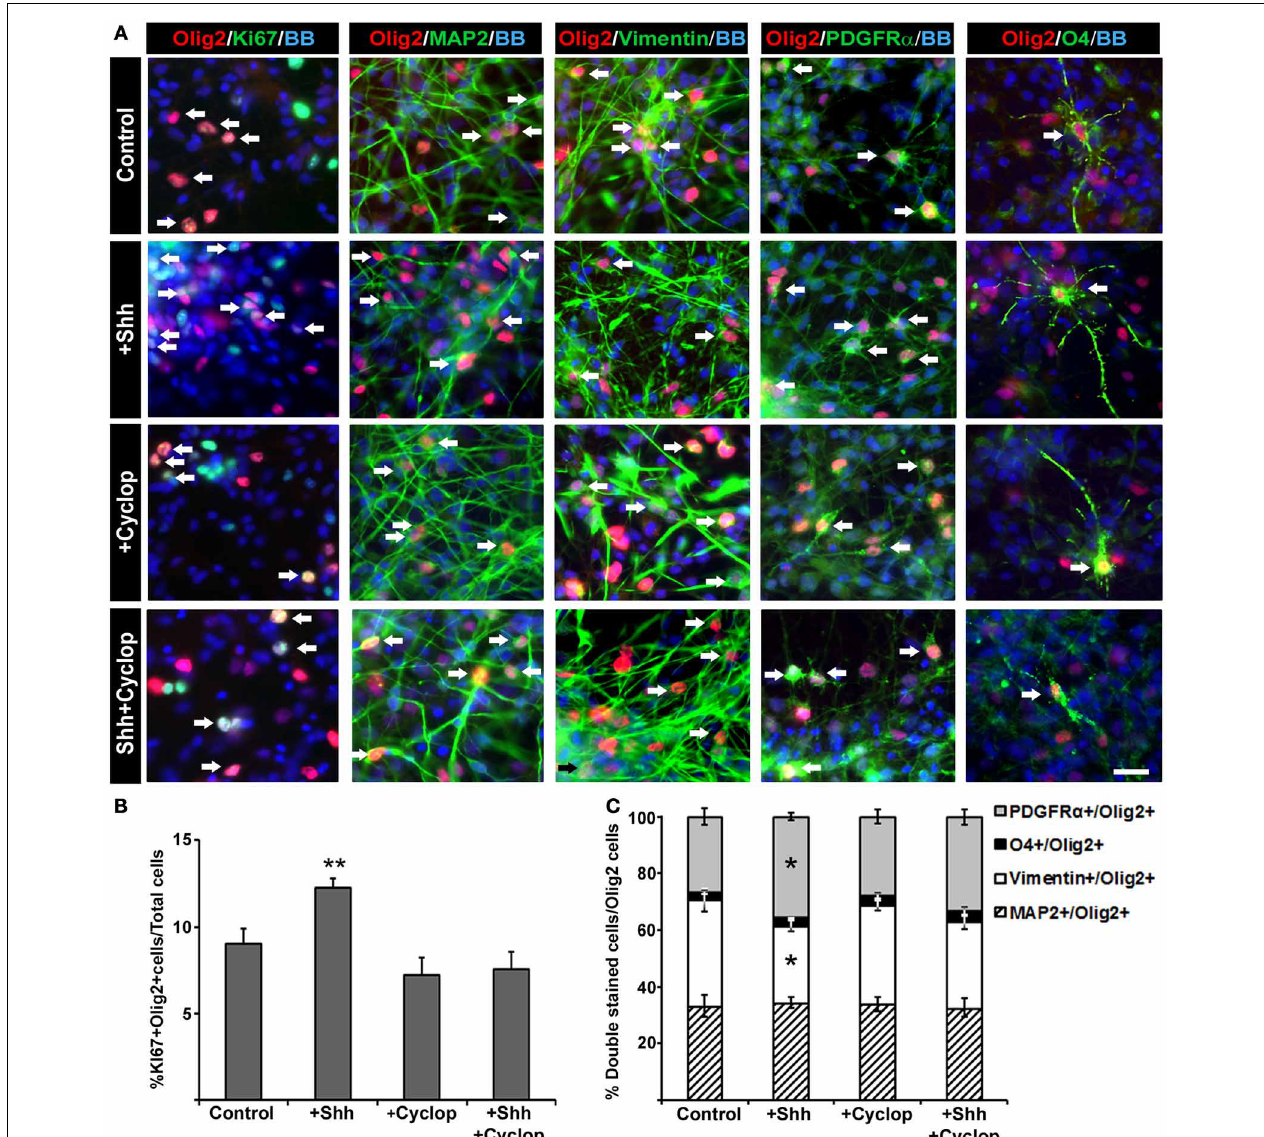
FIGURE 4 | The effect of Shh signaling on proliferation and differentiation of Olig2 + cells in vitro . (A) In mixed cell cultures at midgestation, Olig2 + cells (red) were co-labeled with Ki67 (cell proliferation marker), MAP2 (neuronal marker), vimentin (RGC marker), PDGFR α (early OPC marker) and O4 (late OPC marker) in green. Nuclear staining with bisbenzimide (BB) in blue. Scale bar: 20 μ m. (B) Proliferation of Olig2 + cells, estimated by double-labeling with Ki67, increased after Shh treatment, but did not change after either cyclopamine or combined